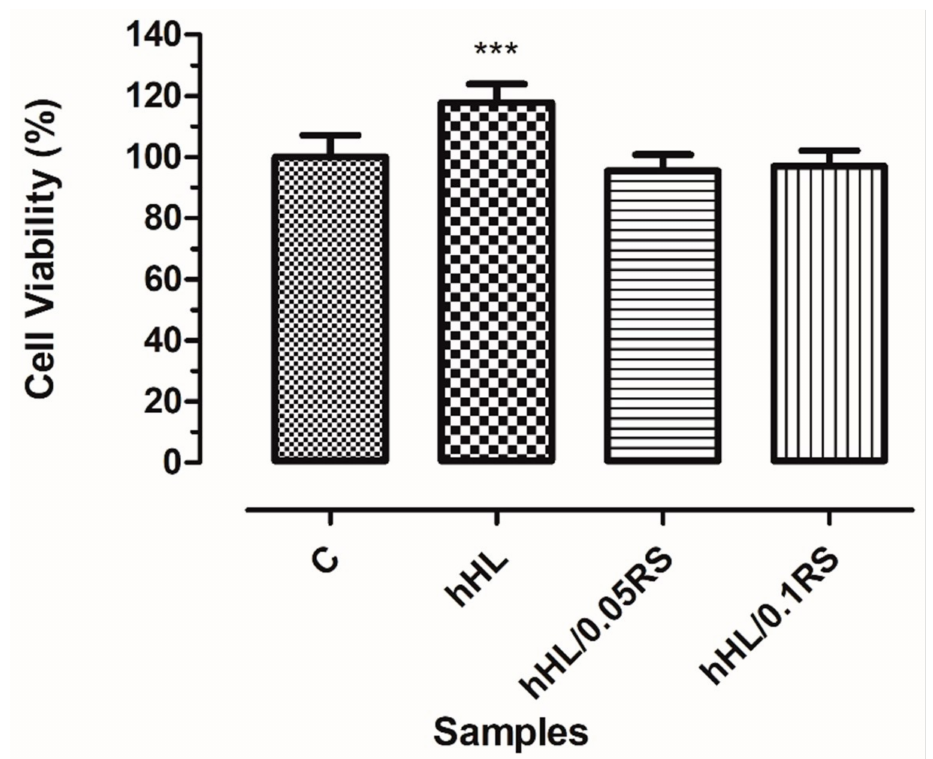
Figure 6. Cell viability results of PCS-201-012 cells after being cultivated with electrosprayed surfaces for 24 h. (A p value below 0.05 is represented as; 0.001 to 0.01 as